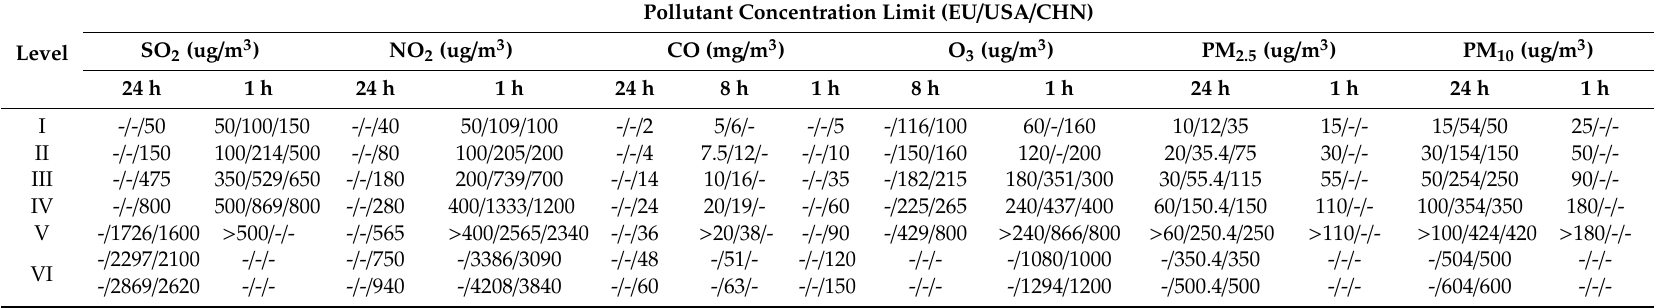
Table 1. The comparison of criterion in EU, USA and